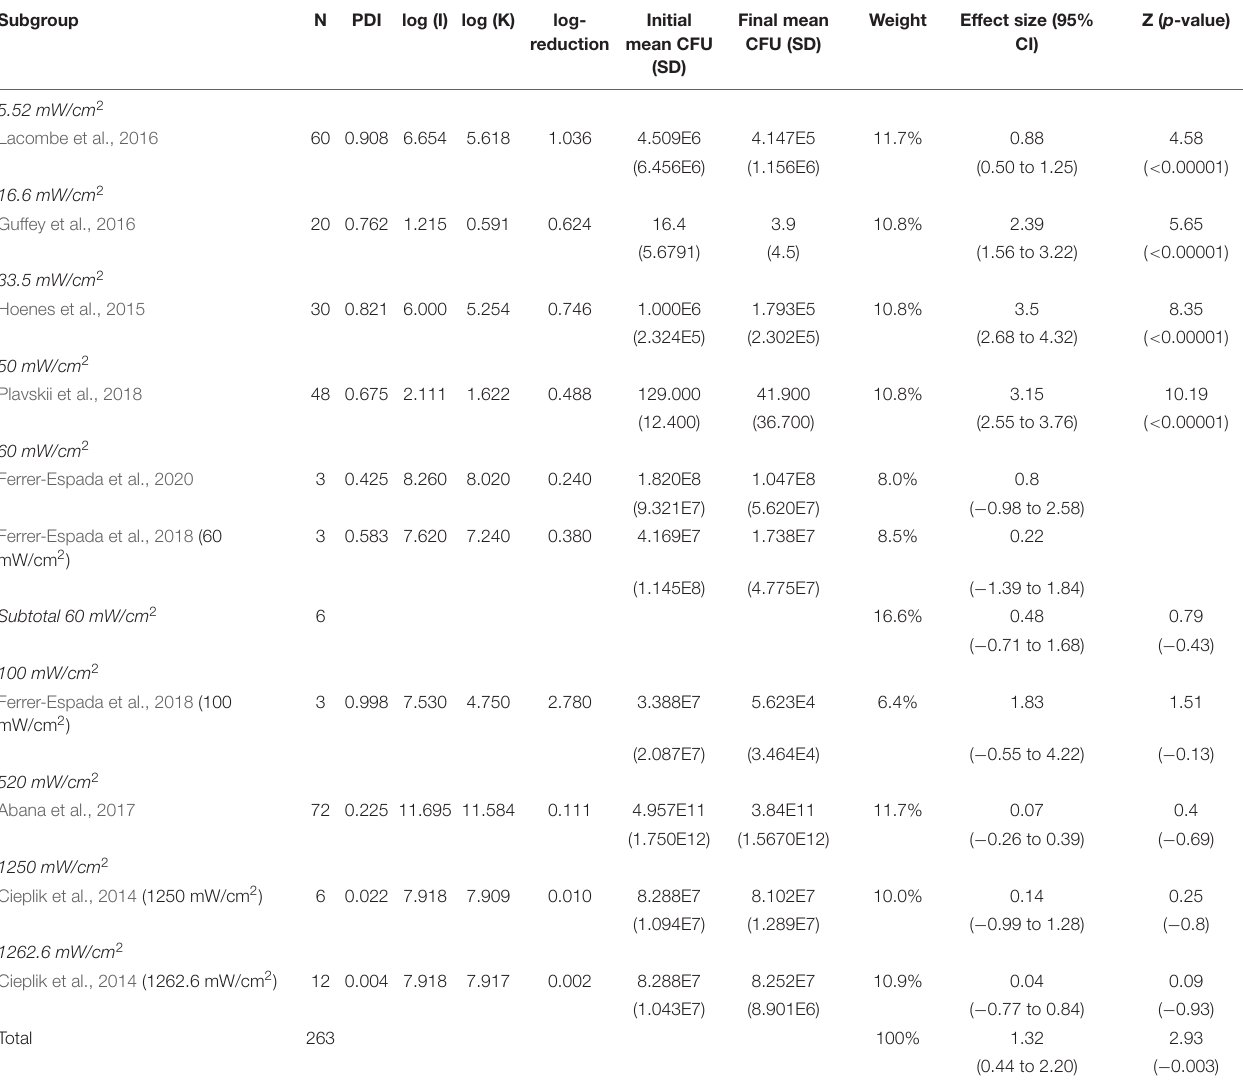
TABLE 3 | CFU E. coli outcomes by intensity.